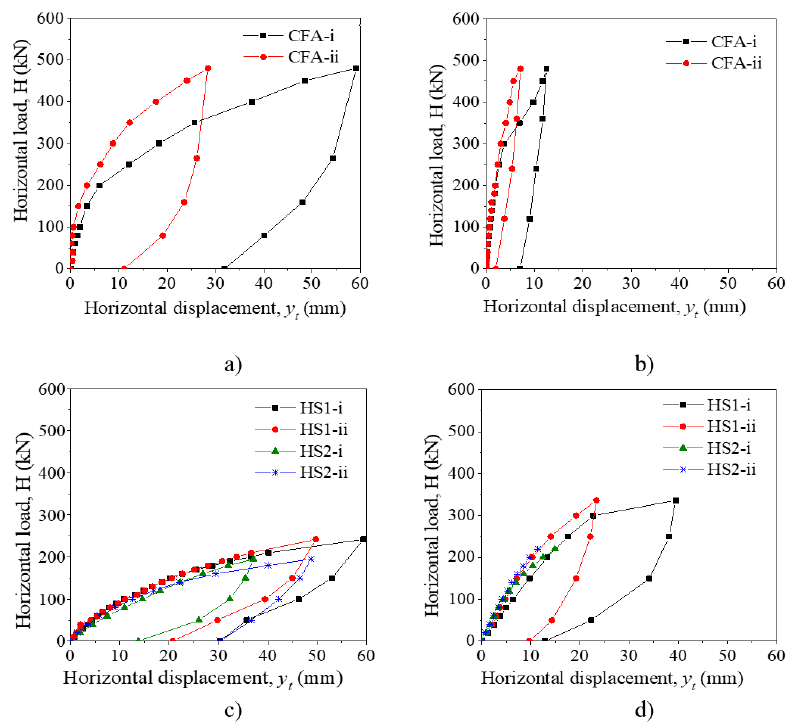
Figure 5. Results of the lateral tests: (a) CFA piles in Area A; (b) CFA piles in Area B; (c) steel H-section piles in Area A; (d) steel H-section piles in Area